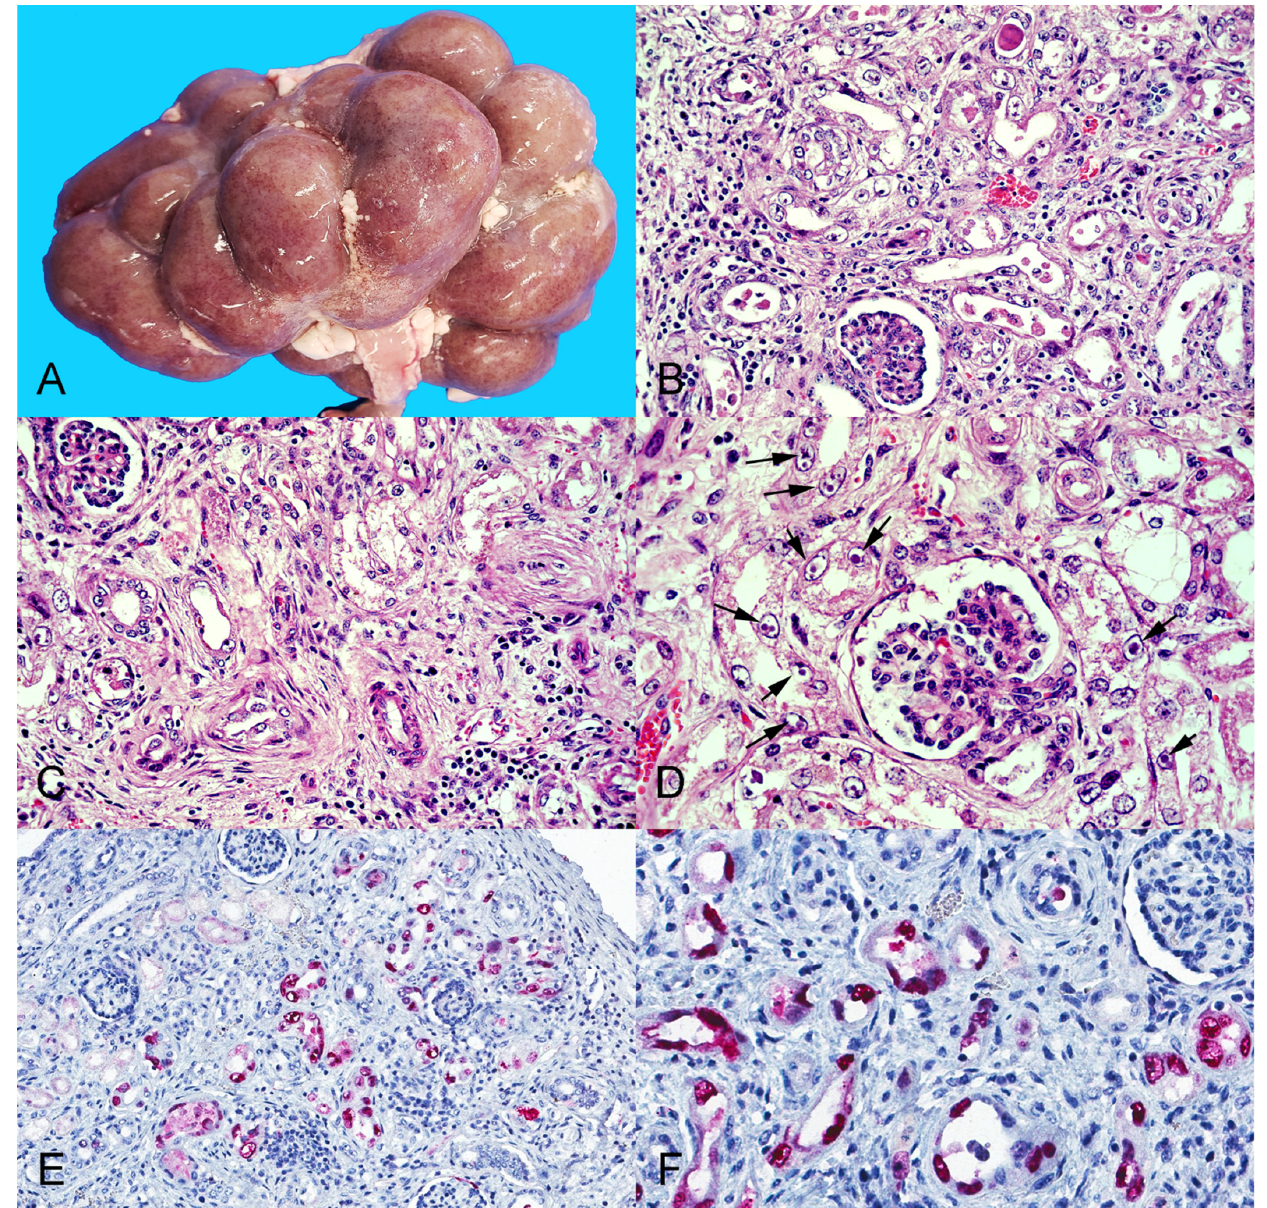
Figure 1. Pathological findings in the kidney of the aborted fetus. ( A ) Grossly, there are numerous discrete pinpoint red foci disseminated throughout the renal cortex that are visible through the capsular surface. ( B ) Cortical tubules are variably ectatic, contain necrotic cellular debris and are lined by either attenuated epithelium, or epithelial cells with markedly swollen vesicular nuclei, occasionally containing one or several magenta intranuclear inclusion bodies. The cortical interstitium is infiltrated by inflammatory cells, predominantly lymphocytes and histiocytes. Hematoxylin and eosin (HE) stain, original magnification 400×. ( C ) Similar histologic lesions as described in B but there is also marked interstitial fibrosis. HE stain, original magnification 400×. ( D ) Numerous cortical tubular epithelial cells have markedly swollen nuclei containing one or several magenta intranuclear inclusion bodies surrounded by a clear halo (arrows), indicating margination of the chromatin. HE stain, original magnification 630×. ( E , F ) Immunoreactivity to polyomavirus LT antigen is demonstrated by red chromogen precipitate largely in the nucleus of cortical tubular epithelial cells. Immunohistochemistry (immunoalkaline phosphatase technique) with a monoclonal primary antibody against SV-40 polyomavirus LT antigen, hematoxylin counterstain, original magnifications 200× ( E ) and 400× ( F ).